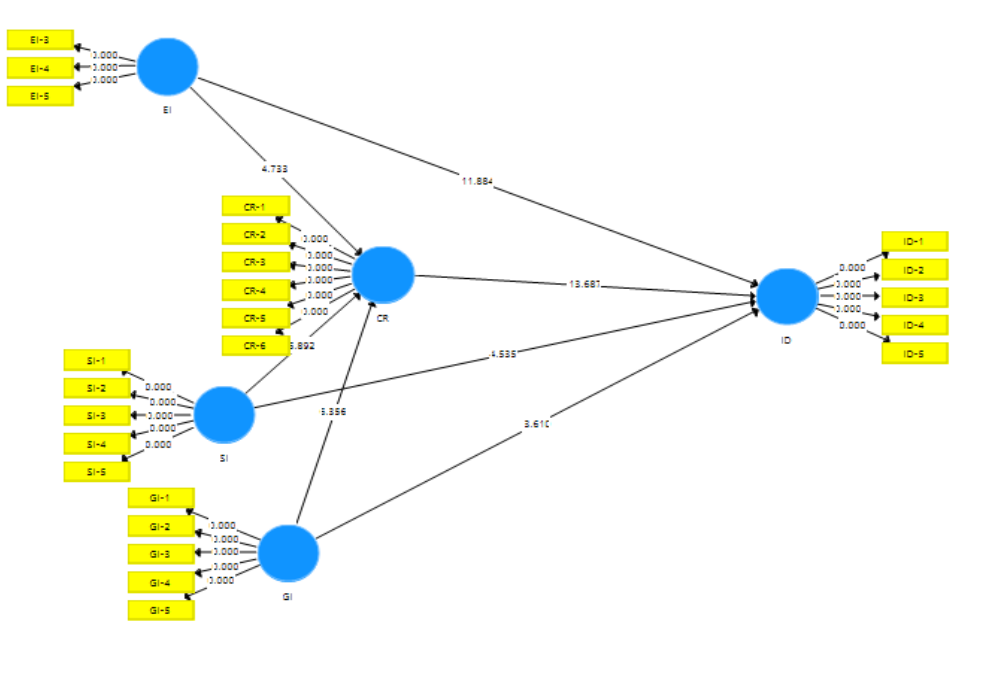
Figure 3: Path Model Significance